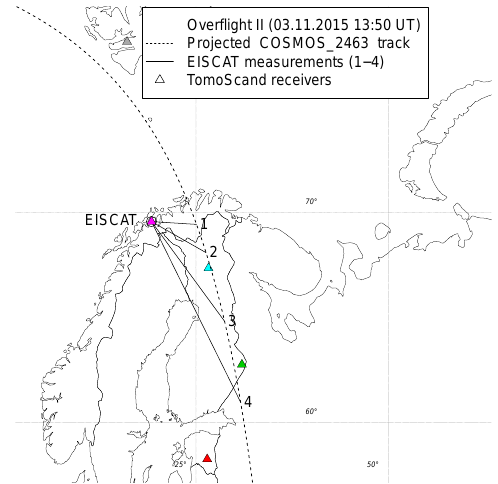
Figure 3. TomoScand receiver network and the satellite overflight ground track with four EISCAT UHF scan paths.